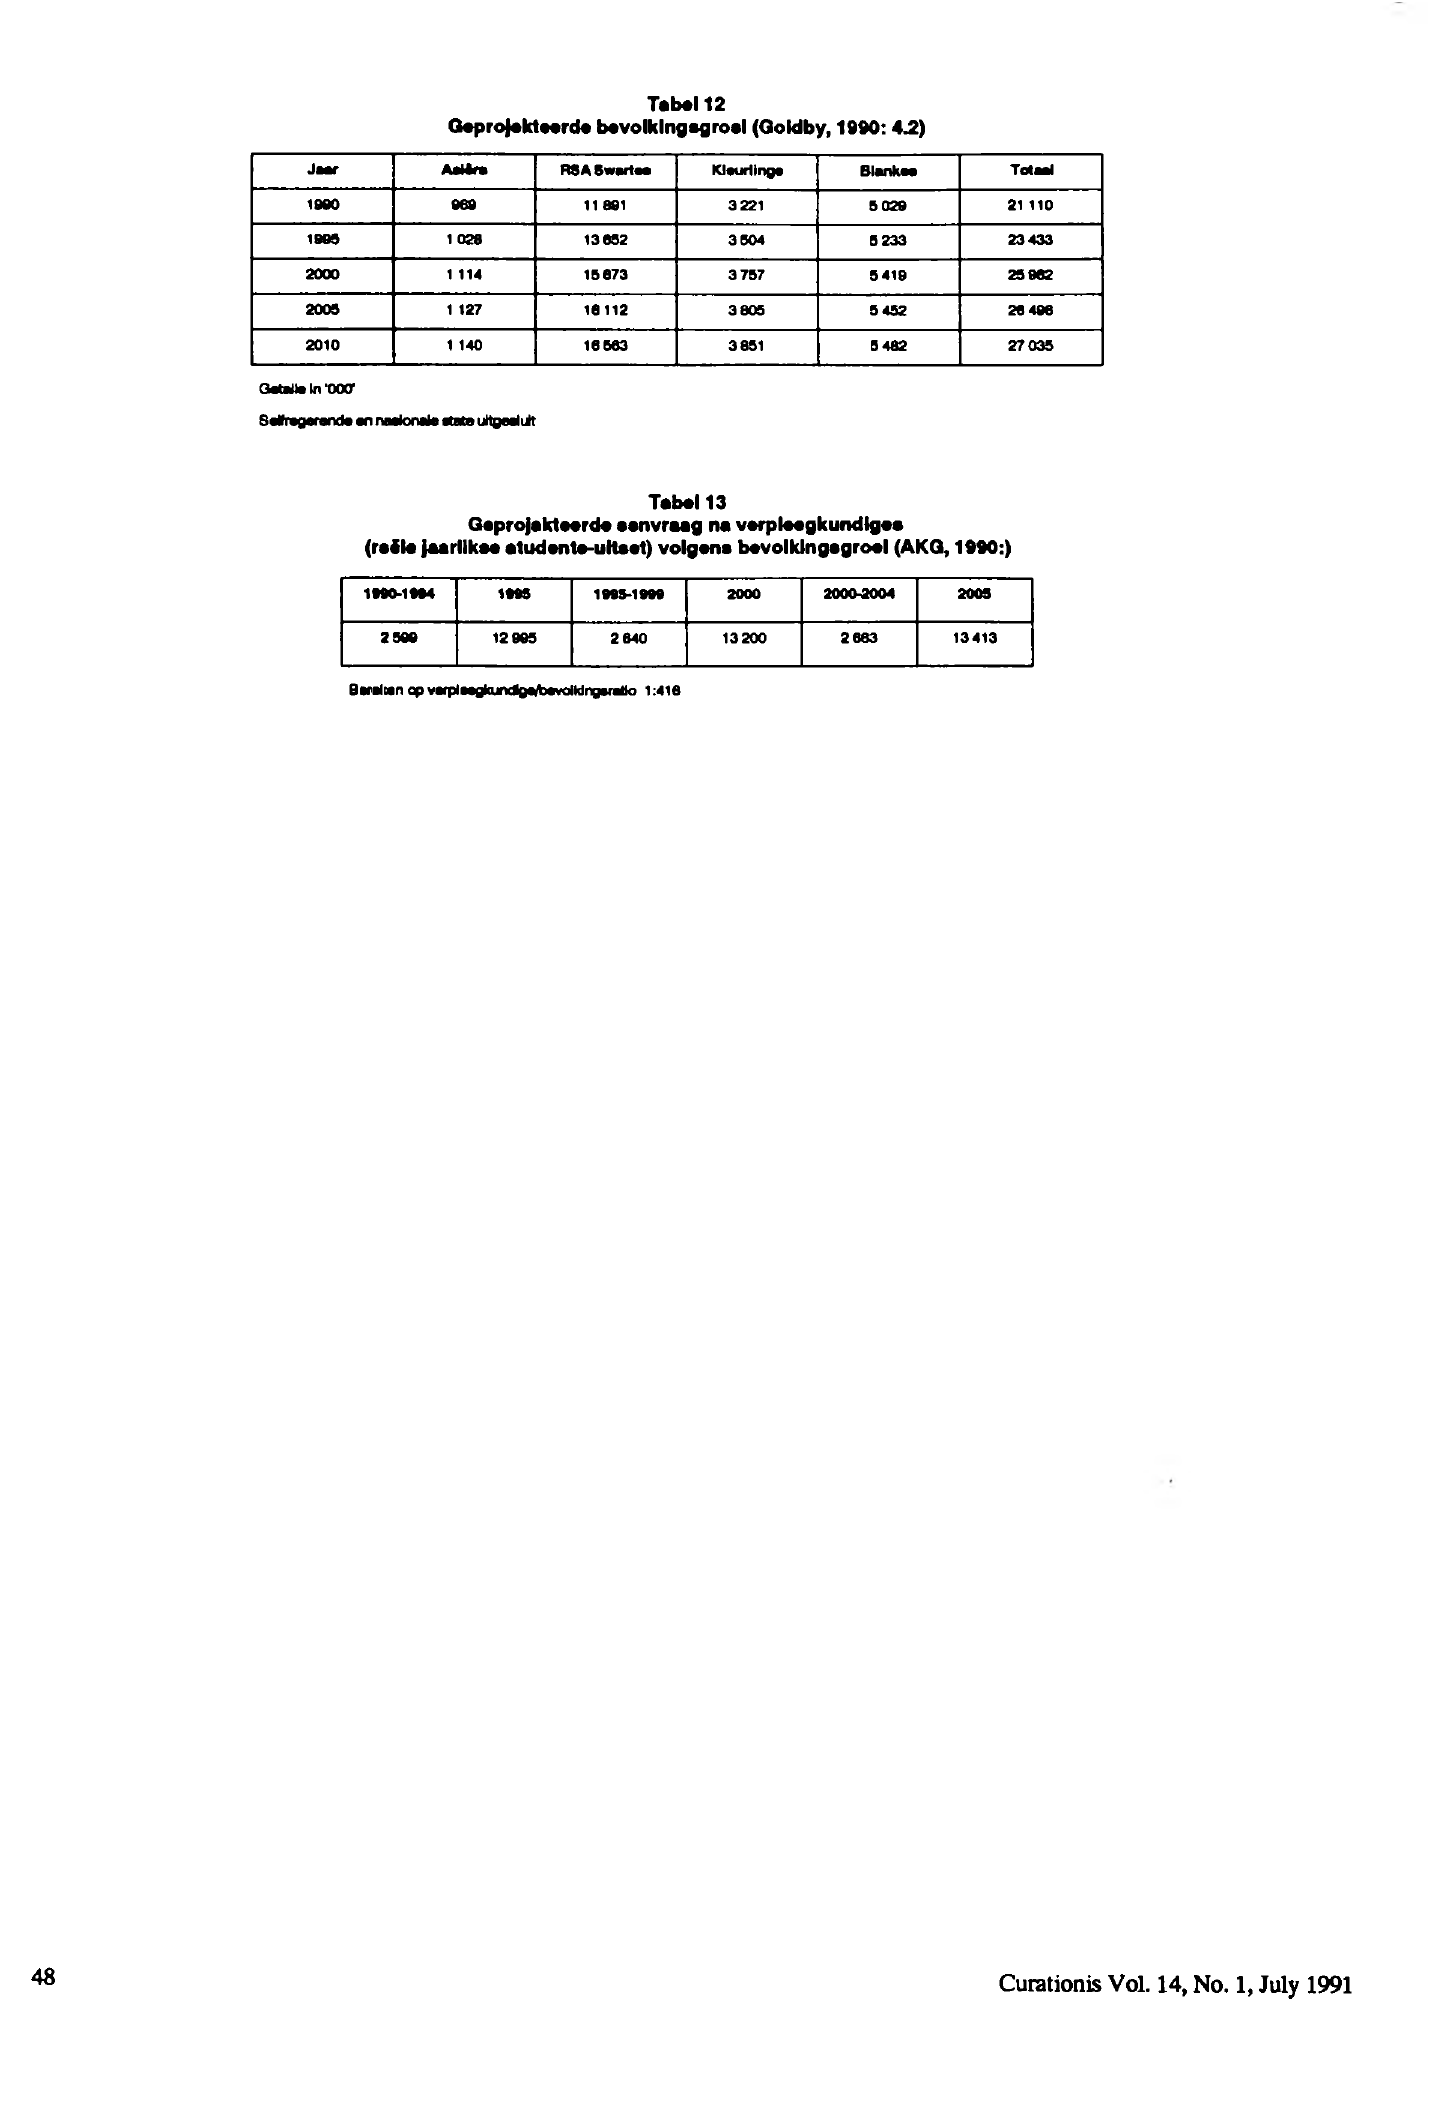
Tabal 13 Gaprojaktaarda aanvraag na varplaagkundlgae (raéla Jaarilkaa atudanta-uttaat) volgana bavolklngagroal (AKQ,